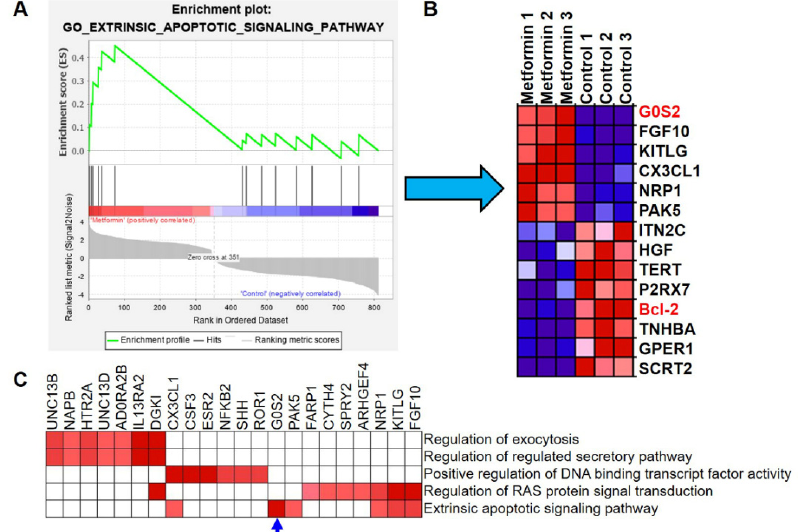
Figure 5. G0S2 is the most significant and positive correlated protein with the extrinsic apoptotic signaling pathway in metformin-treated macrophages. ( A ) Enrichment plot of the extrinsic apoptotic signaling pathway in the data set, includ- ing the ES score and positions of GeneSet members on the rank-ordered list. ( B ) Heat map of the analyzed GeneSet in the extrinsic apoptotic signaling pathway. ( C ) Heat map of top five pathways clustered leading edge subsets. Rows are gene sets and columns are genes. This matrix is clustered.